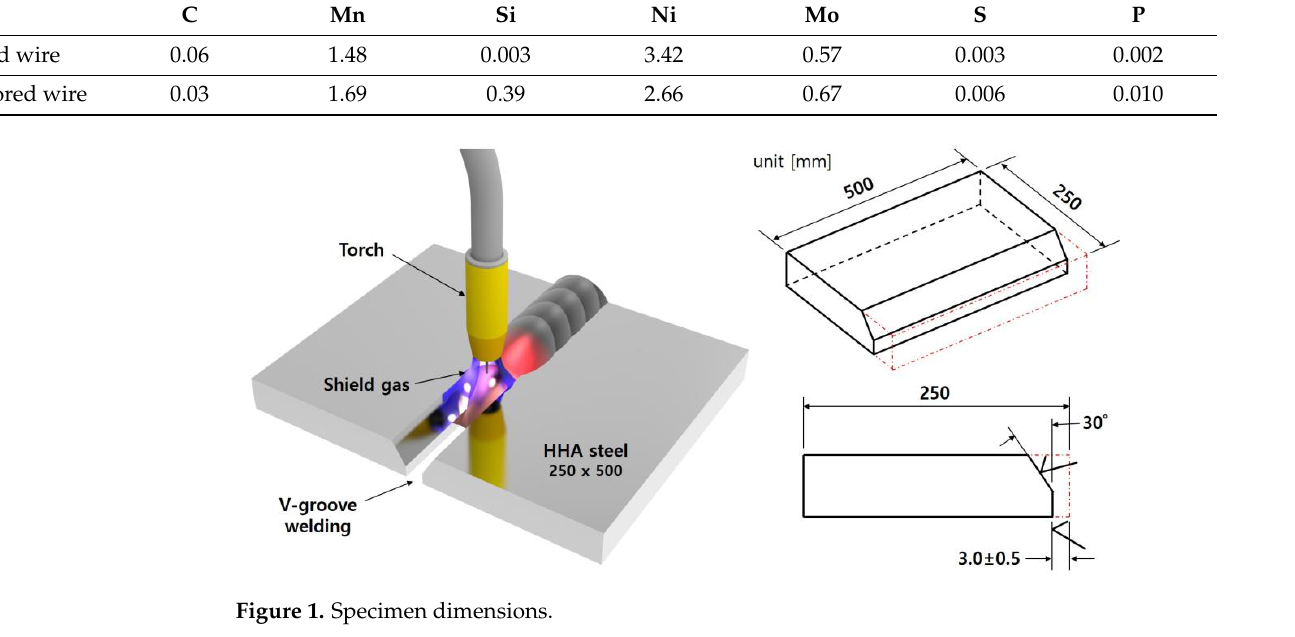
Table 2. Chemical properties of solid and flux cored wire (wt%).